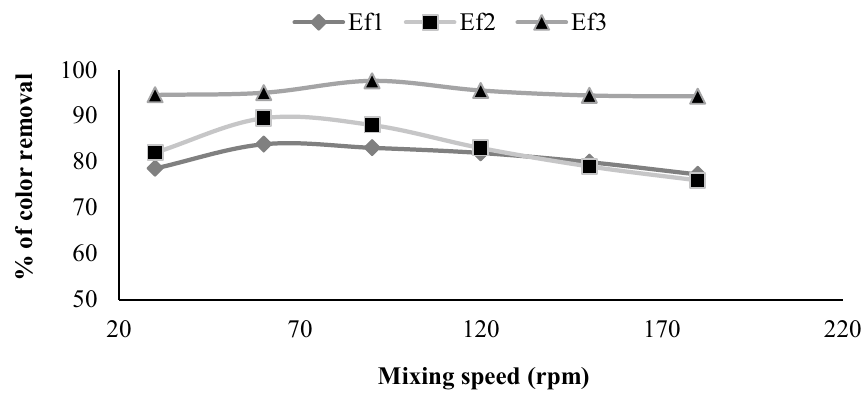
Fig. 3 Effect of mixing speed on the color removal efficiency of the coagulants from the tex- tile dyeing effluents (pH = 7.0, coagulant dose 300 mg/Land temperature 30 °C for PAC coagulant)